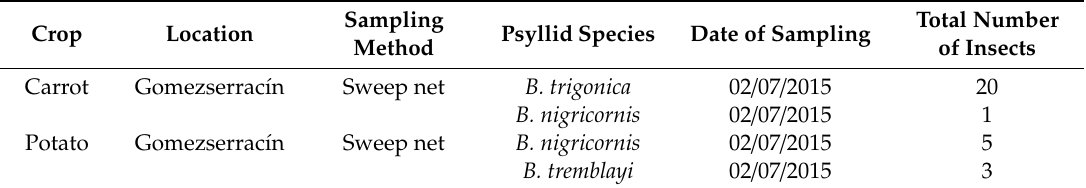
Table 2. Survey of adult psyllids associated with carrot and potato fields in Gomezserrac í n (Segovia) Spain conducted in July 2015.